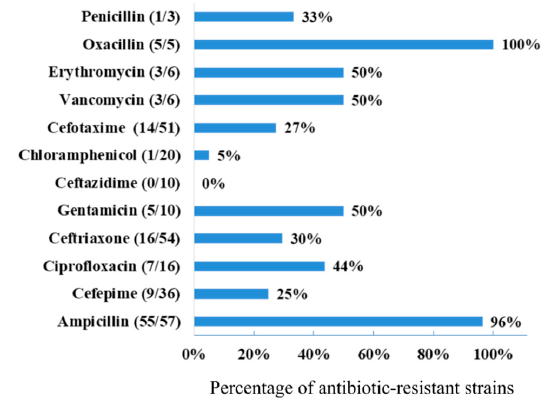
Figure 2. Percentage of antibiotic resistance of bacterial isolates from UTI patients.